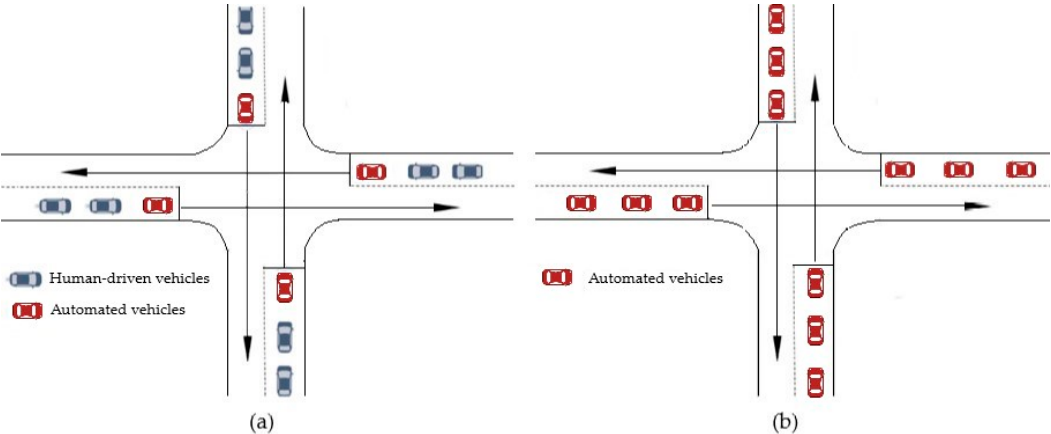
Figure 5. Leading autonomous vehicle experiments at a non-signalized intersection: ( a ) mixed- autonomy traffic with autonomous vehicle (AV) penetration rates ranging from 10% to 90% in 10% increments; ( b ) full-autonomy traffic with a 100% AV penetration rate.